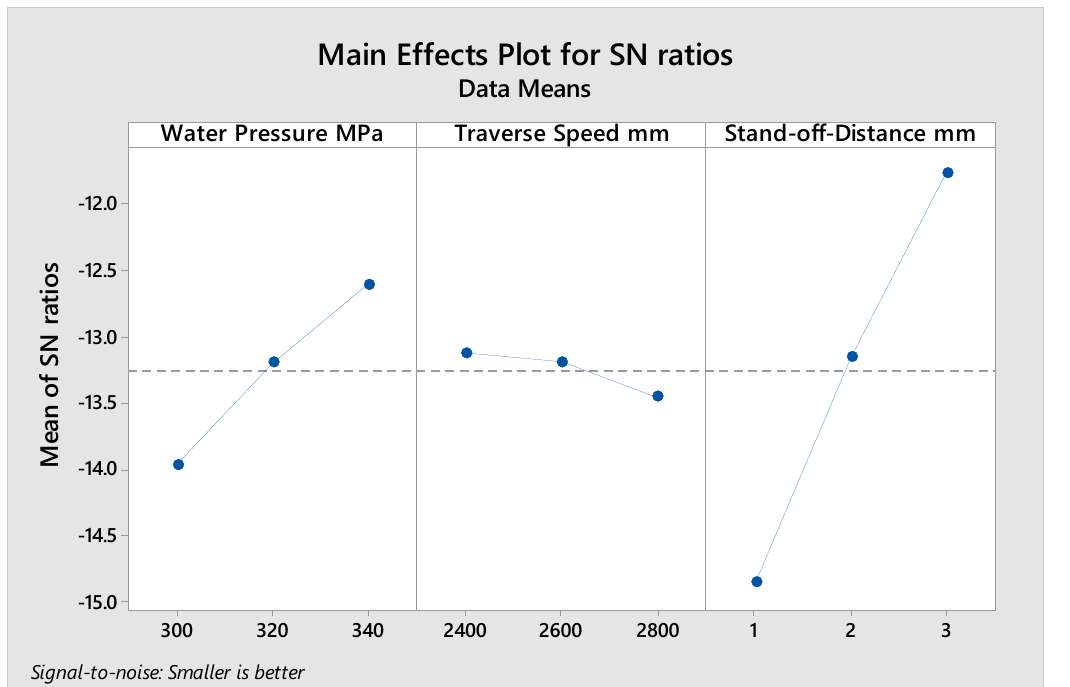
Figure 8. S/N ratio average value of input cutting parameters of the 2 mm thickness of sugar palm fiber reinforced unsaturated polyester (SPF-UPE) composite cut with abrasive water jet technique. Table 17. S/N ratio response table of input cutting parameters of the 2 mm thickness off SPF-UPE composite cut with abrasive water jet technique.